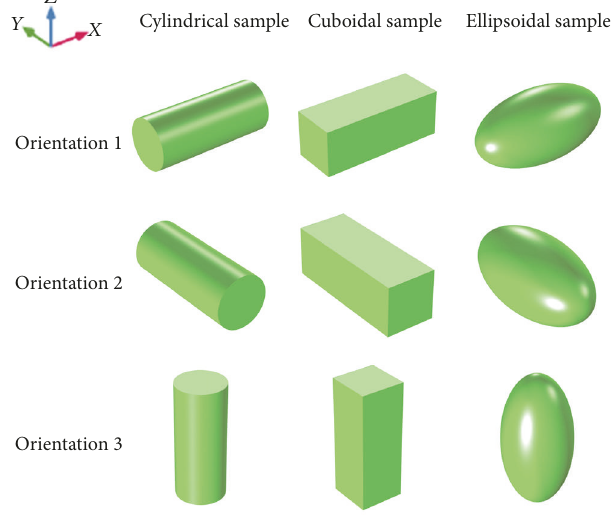
Figure 16: Sample